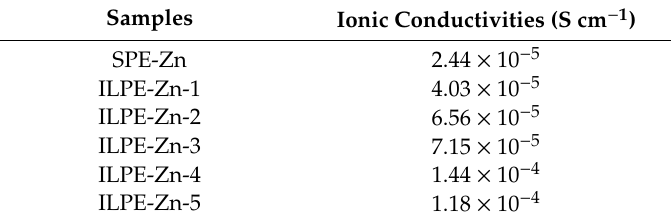
Figure 4. ( a ) Nyquist plots of the ILPE membranes with different EMITf contents measured at ambient temperature and corresponding equivalent circuit (CPE = constant phase element, R b = resistor, and C dl = double-layer capacitor). ( b ) Variation of ambient temperature ionic conductivity with the mass ratio of EMTIf to PVdF-HFP. ( c ) DC polarization curve of ILPE-Zn-4 membrane under 0.5 V at room temperature. ( d ) The ILPE-Zn-4 membrane used as an ionic conductor to successfully connect the LED circuit. Table 1. Ionic conductivities of polymer electrolyte membranes at room temperature.